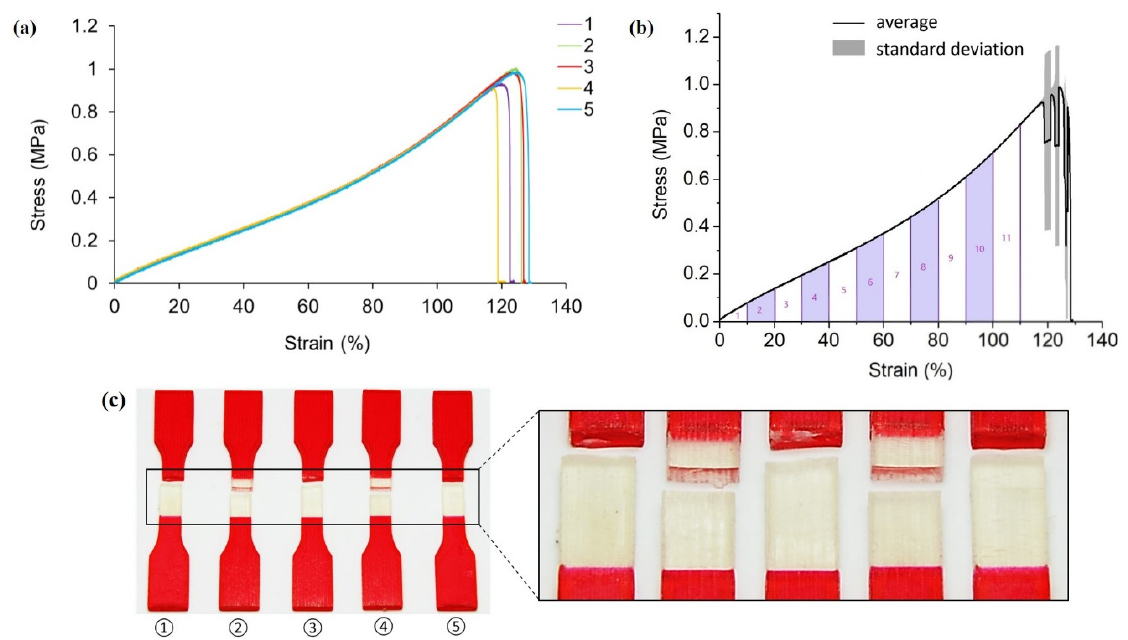
Figure 4. ( a ) Stress-strain curves obtained from tensile testing tests on non-reinforced A30 samples; ( b ) average tensile stress—strain curve and standard deviation of all five testings; ( c ) pictures of failed tensile samples with zoom-in at the locations of fracture.